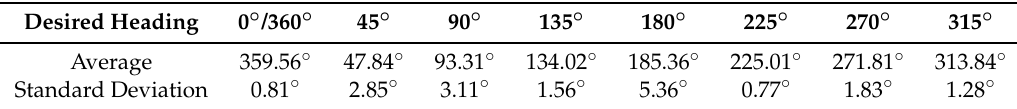
Table 13. Heading measurement values.